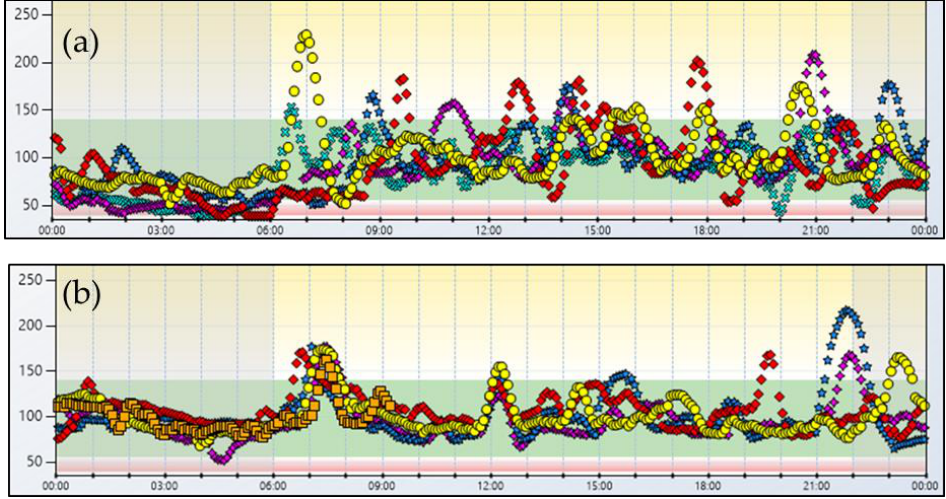
Figure 2. Case 2. 5-day glucose profile before ( a ) and after ( b ) nutritional intervention.